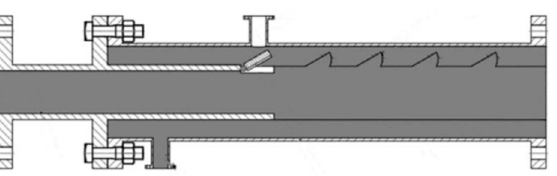
Figure 17. The wedge wave generator [59].